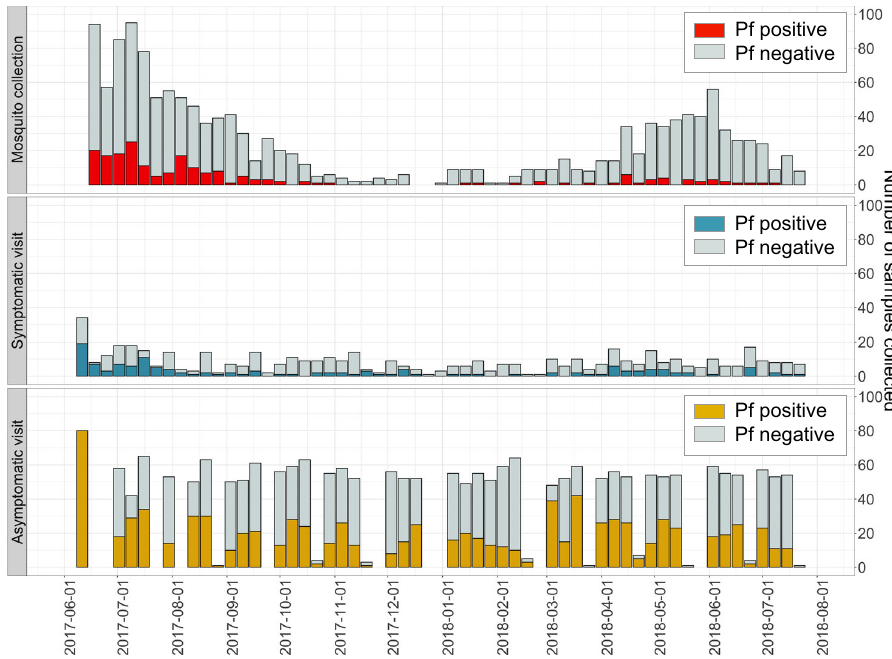
Fig. 1 P. falciparum infections observed across study participants and female Anopheles mosquitoes across 14 months. Female Anopheline mosquitoes were captured weekly by vacuum aspiration and their abdomens were tested using real-time PCR for the presence (red) or absence (gray) of P. falciparum (Pf) parasites. Symptomatic malaria infections were captured by passive case detection with clinical symptoms and positive P. falciparum results by both RDT and real-time PCR (blue). The number of participants who had malaria-like symptoms and requested a symptomatic visit but did not have a con fi rmed symptomatic infection were also identi fi ed (gray). Asymptomatic malaria infections were captured by active case detection at monthly follow-up visits with participants and real-time PCR-positive for P. falciparum . These monthly visits were conducted in different weeks for each of the three villages, with additional re-visits if needed to sample enrolled participants who were absent for the initial visit. Monthly counts of asymptomatic malaria infections (yellow) and uninfected participants (gray) were